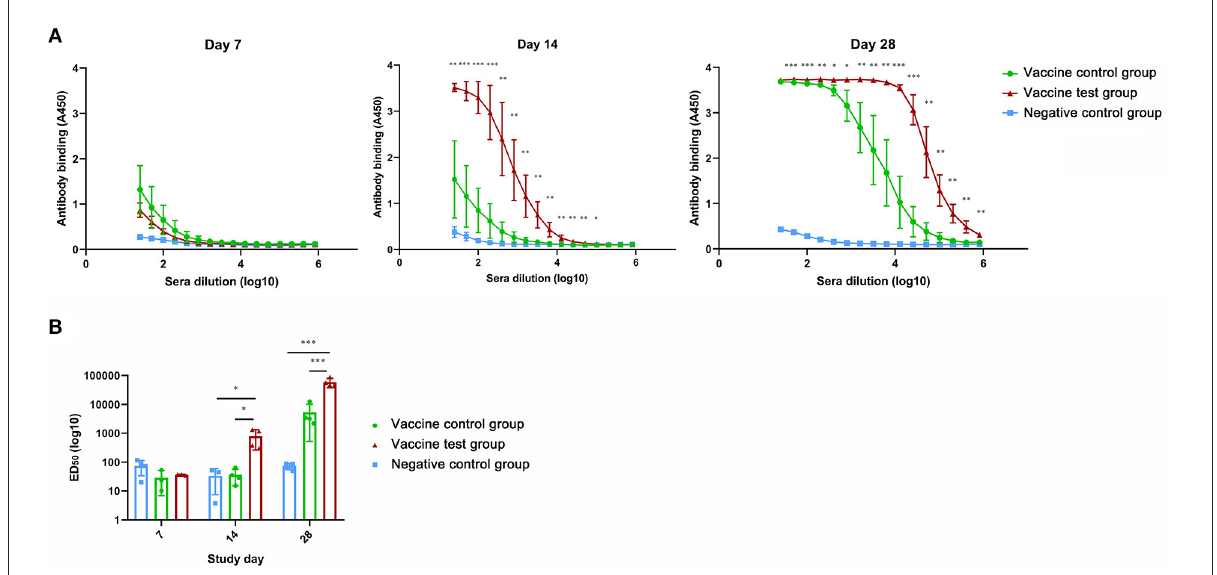
FIGURE1 Anti-spike protein (B.1.617.2) IgG antibody titers in mice serum of three groups. (A) Anti-spike protein (B.1.617.2) IgG antibody titers in mice serum of three groups at day 7, 14, and 28. (B) Comparisons of ED 50 titers of mice serum Anti-spike protein (B.1.617.2) IgG antibody in three groups at day 28 (Vaccine test group, n = 4; Vaccine control group, n = 4; Negative control group, n = 4; * p < 0.05; ** p < 0.01; *** p < 0.001 p < 0.05 was considered statistically significant.).